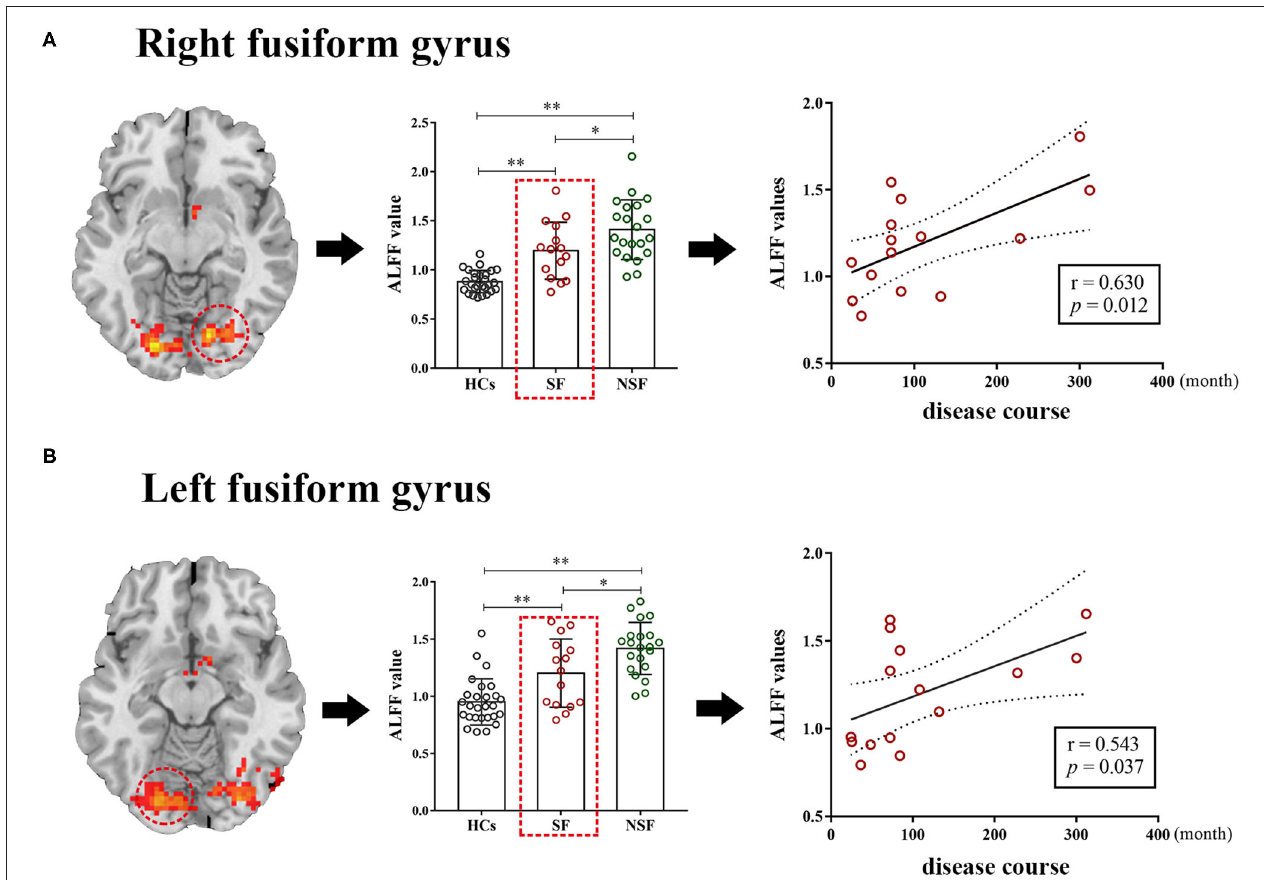
FIGURE 3 | The correlation between the ALFF values and clinical characteristics. The ALFF values of the right fusiform gyrus ( r = 0.630, p = 0.012) and left fusiform gyrus ( r = 0.543, p = 0.037) were positively correlated with disease course in the SF group respectively (A,B) . ** p < 0.01, * p < 0.05 after Bonferroni correction of post-hoc analysis. ALFF, the amplitude of low-frequency fluctuation; SF, seizure-free; NSF, non-seizure-free; HCs, healthy